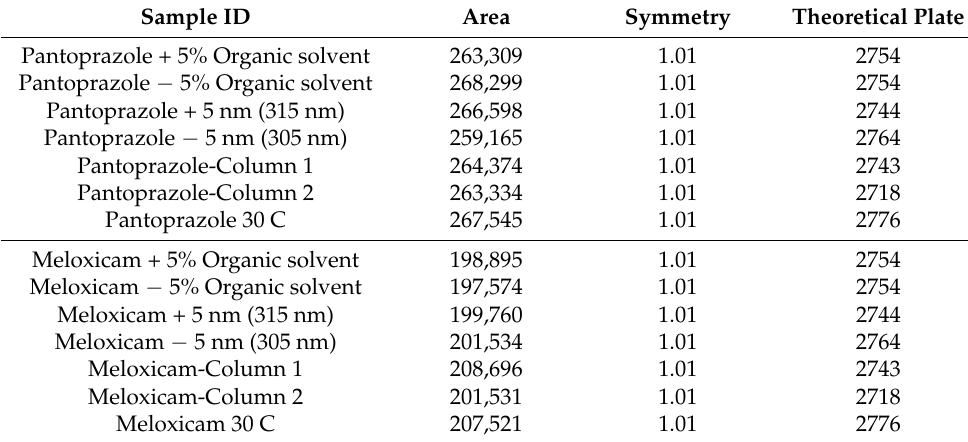
Table 9. Robustness of pantoprazole and